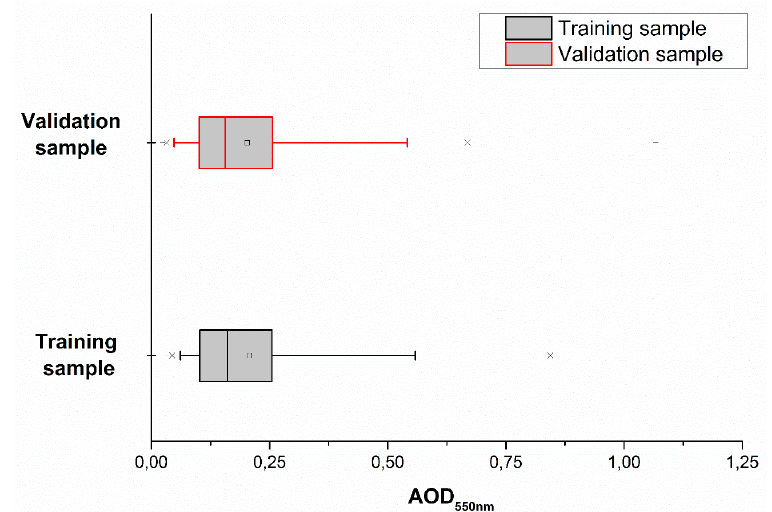
Figure 3. Box plots for the distributions of training and validation samples of aerosol optical depth at 550 nm (AOD 550 nm ) values.